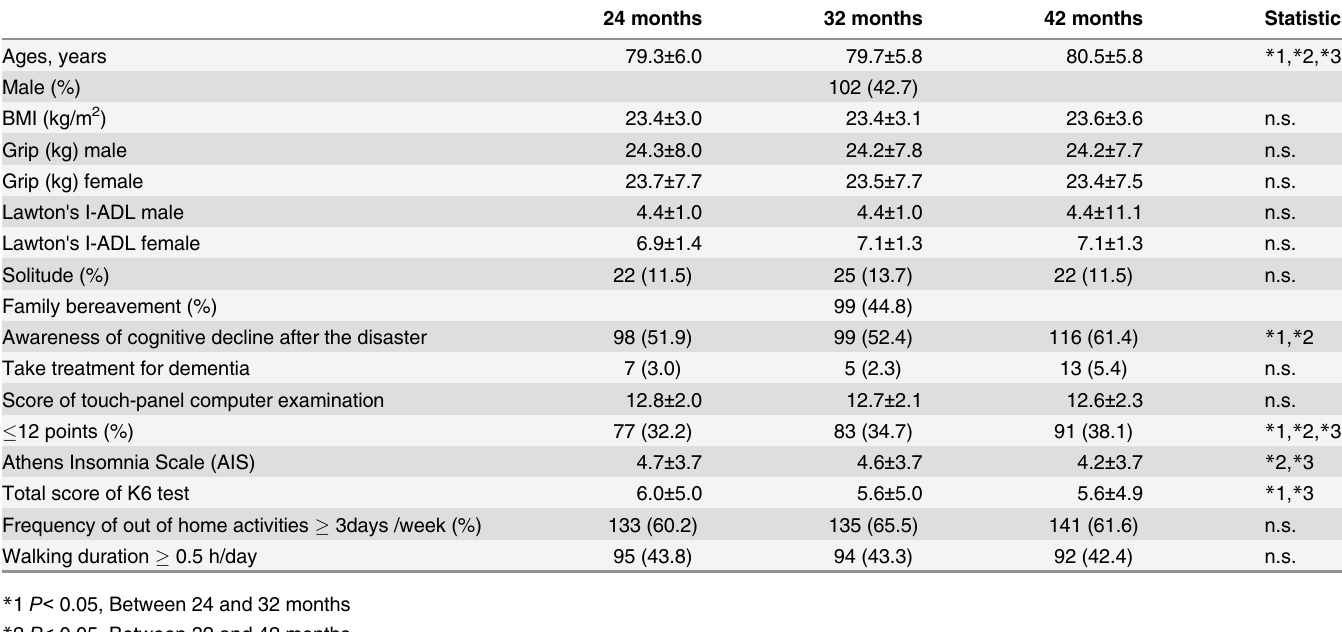
Table 1. Change in each item at 24, 32, and 42 months after the disaster.